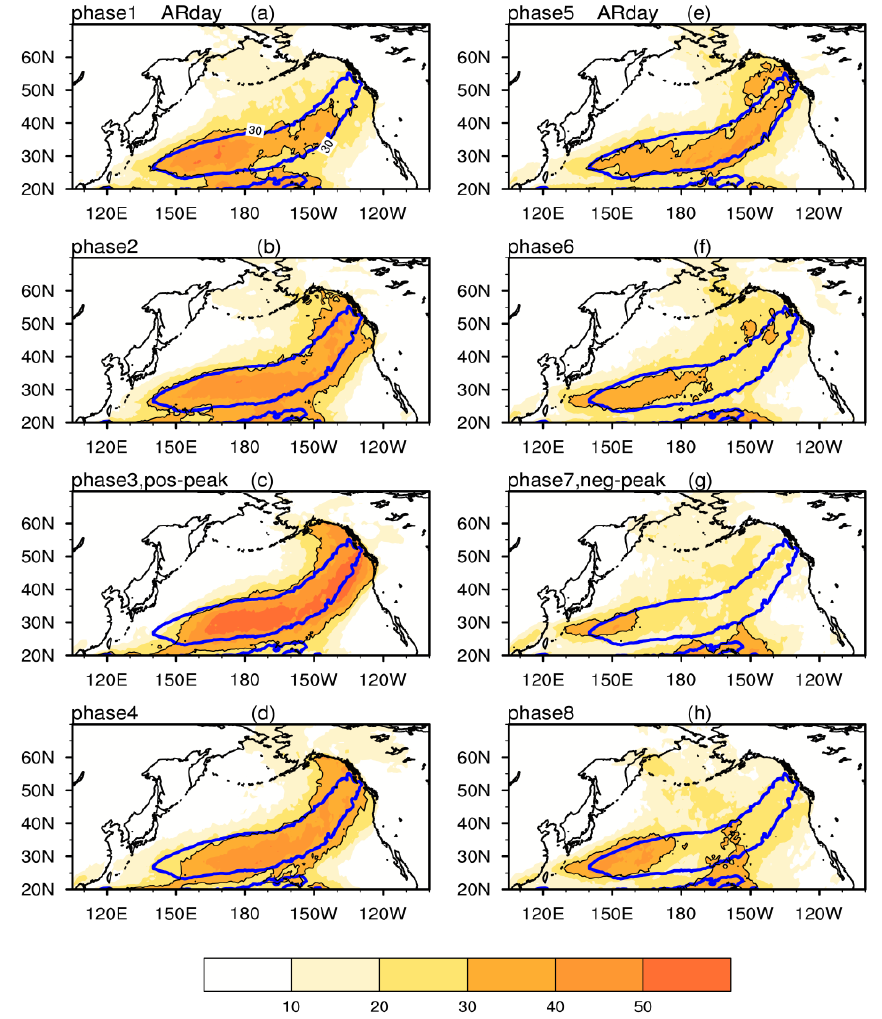
Figure 5. As in Figure 4, but for atmospheric river (AR) frequency (%). Blue contours indicate the climatological winter AR frequency of 30%. ( a ) to ( h ) corresponding to phases 1 to 8. Composite fields of IVT and ∇· IVT in phases three and seven for group AR days and non-AR